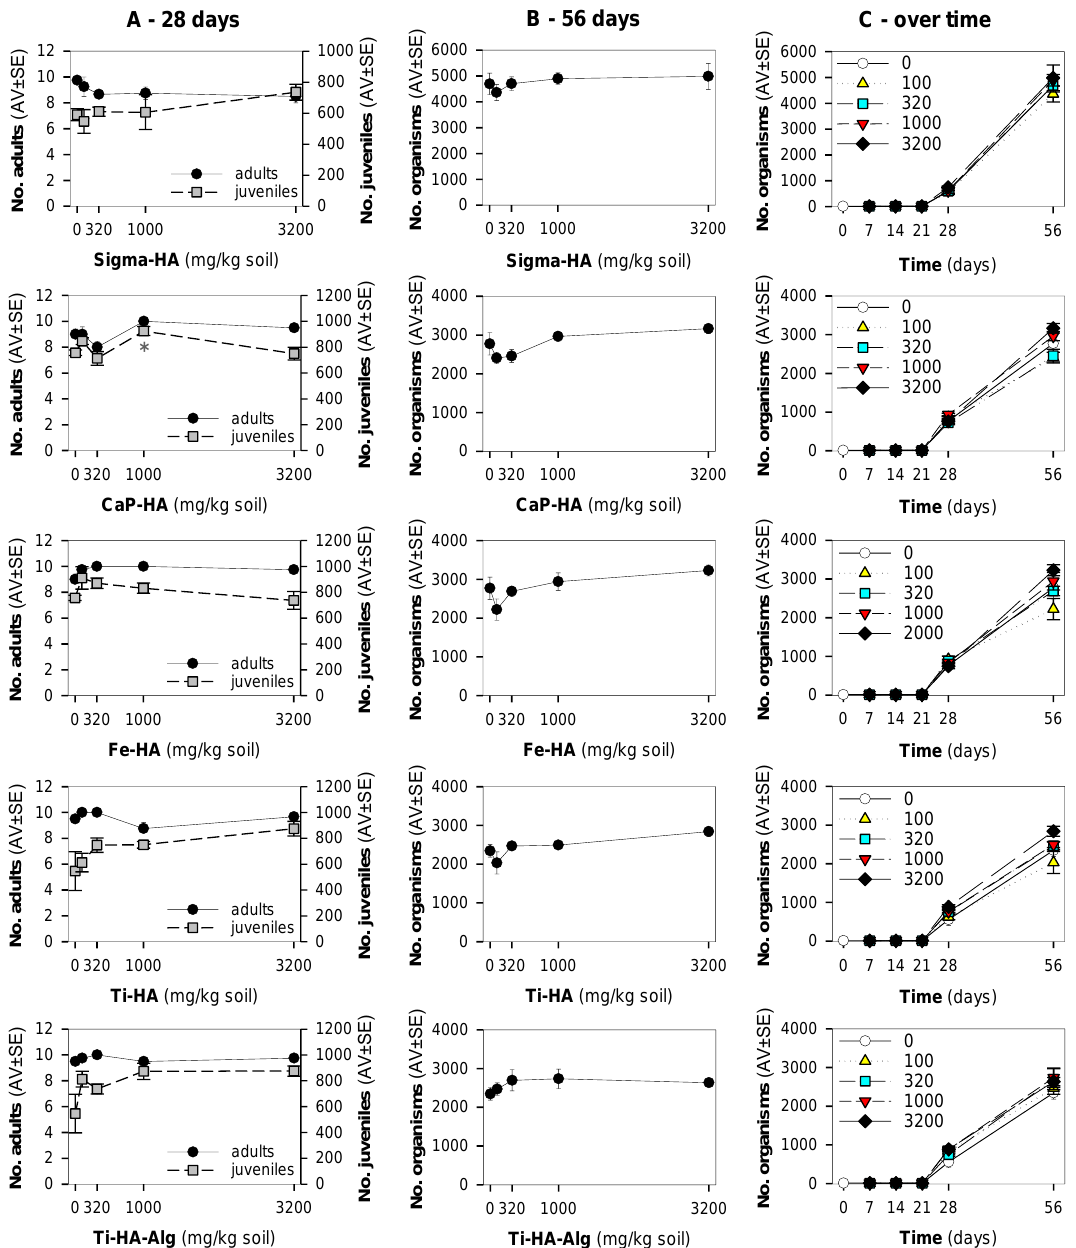
Figure 1. The results in terms of survival and reproduction from the Enchytraeid Reproduction Test, when exposing Enchytraeus crypticus in LUFA 2.2 soil to the commercial hydroxyapatite (Sigma-HA), calcium hydroxyapatite (CaP-HA), superparamagnetic iron doped hydroxyapatite (Fe-HA), and titanium-doped hydroxyapatite nanoparticles (Ti-HA), alginate/titanium-doped hydroxyapatite hybrid particles (Ti-HA-Alg) during ( A ) 28 days (OECD Standard), ( B ) 56 days (OECD standard extension), and ( C ) overview of the time series sampling at days: 7, 14, 21, 28 and 56 days. Values represent number of adults, juveniles, and population as average ± standard error (AV ± SE). *: p < 0.05 (Dunnett’s